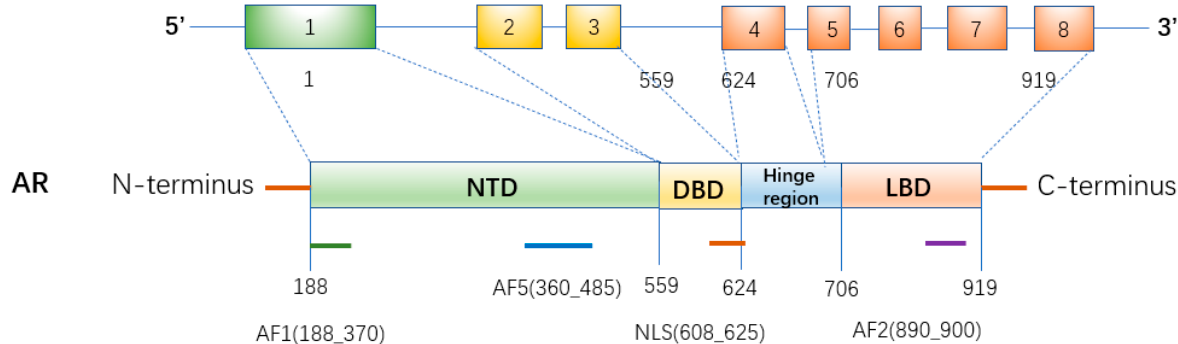
Figure 1. Domain diagram of two isotypes of androgen receptor. AR gene contains eight exons: exon 1 encodes n-terminal domain (NTD); exon 2 and 3 encode DNA binding domain (DBD). Exon 4-8 encodes the hinge region and c-terminal ligand binding domain (LBD). The hinge region containing the nuclear localization signal is encoded by the 5 ′ region of exon 4. Activation function (AF) is active functional domain. NLS is nuclear localization signal (NLS). The lower numbers refer to amino acid residues that separate domains from the N-terminal (left) to the C-terminal (right).